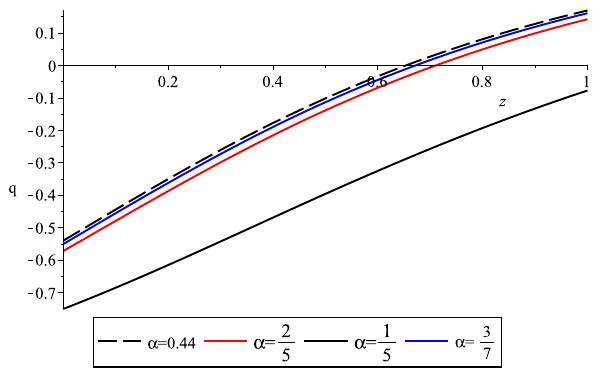
Fig. 1 Deceleration parameter q versus the redshift z for some values of